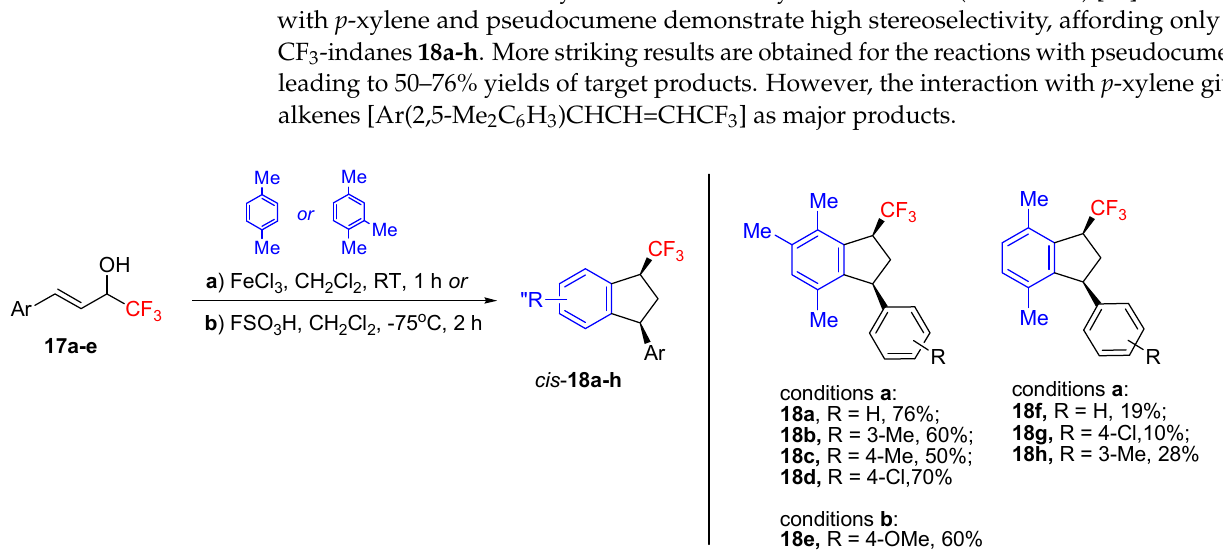
Scheme 12. Stereoselective synthesis of cis- 1-CF 3 -indanes 18a-h from CF 3 -allyl alcohols 17a-e and donating arenes under the action of Lewis acid FeCl 3 or Brønsted superacid FSO 3 H.